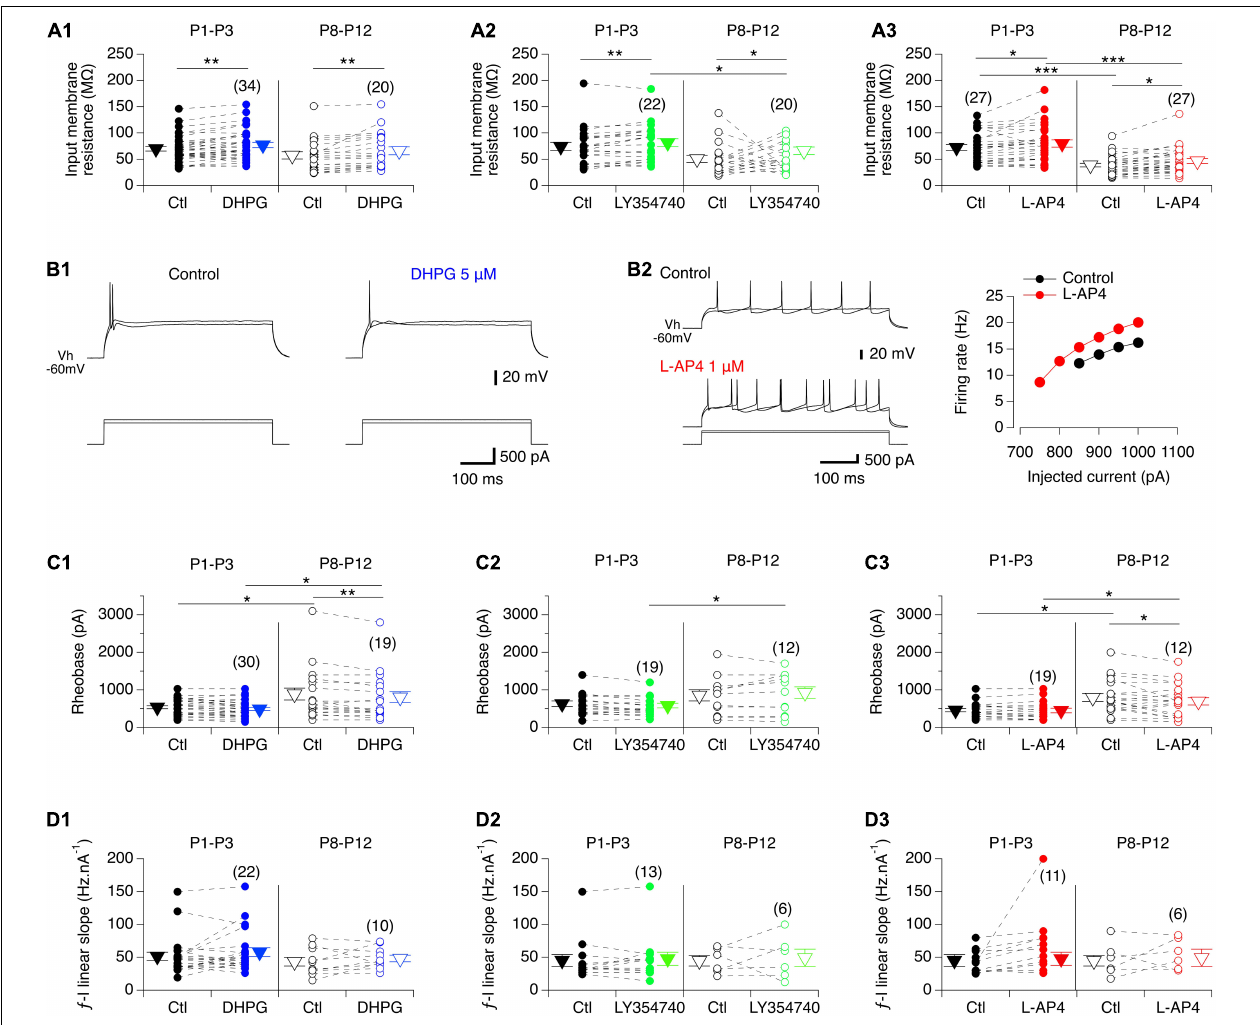
FIGURE 4 | Effects of the three mGluR agonists on membrane input resistance and firing properties of lumbar MNs. (A) Scatter plots with connecting lines (dashed) of mean membrane input resistance of P1-P3 (filled circles) and P8-P12 MNs (open circles) before (black circles) and after exposure to DHPG (blue circles, A1 ), LY354740 (green circles, A2 ) or L-AP4 (red circles, A3 ). All three compounds significantly increased the membrane input resistance of MNs regardless of the developmental stage tested. (B) Representative traces of membrane potential responses to injected depolarizing pulses in the absence and presence of DHPG in a P3 MN (B1) or of L-AP4 in a P8 MN (left panel in B2 ; right panel: corresponding plot of the mean spike frequency as a function of the injected current). (C) Same data representations as in A for the rheobase. DHPG and L-AP4 significantly decreased the rheobase value in MNs at P8-P12. (D) Same data representations as in A for the slope of the f -I relationships showing that none of the three mGluR agonists tested altered this parameter. The triangles correspond to means ± sem of the population tested in each condition and numbers in parentheses to the number of MNs tested. Two-way RM ANOVA followed by Sidak’s post hoc tests, * p < 0.05 and ** p < 0.01 significantly